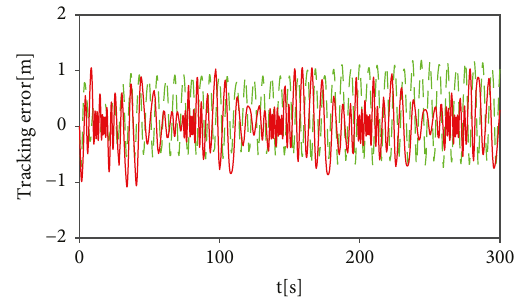
Figure 15: Tracking error